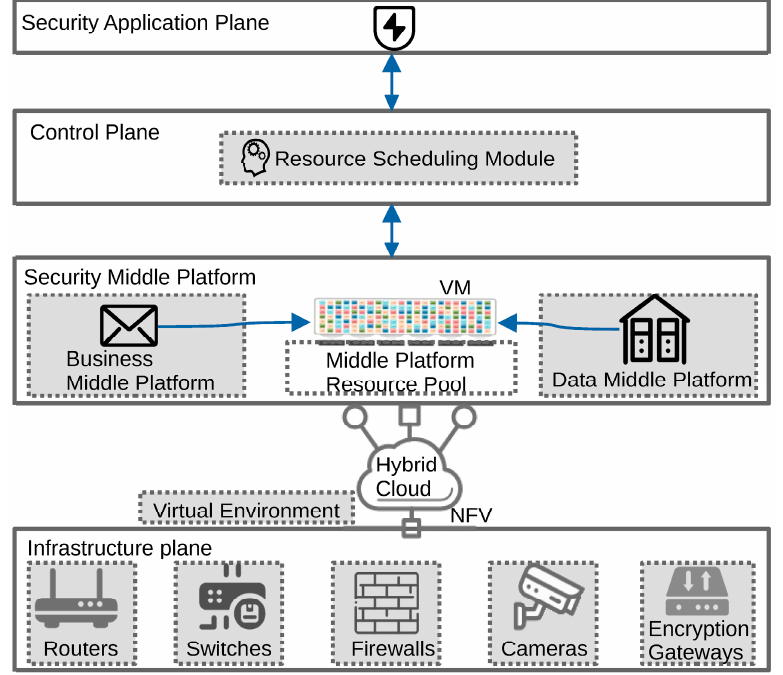
Figure 1. Software-defined security middle platform architecture (SDSmp).